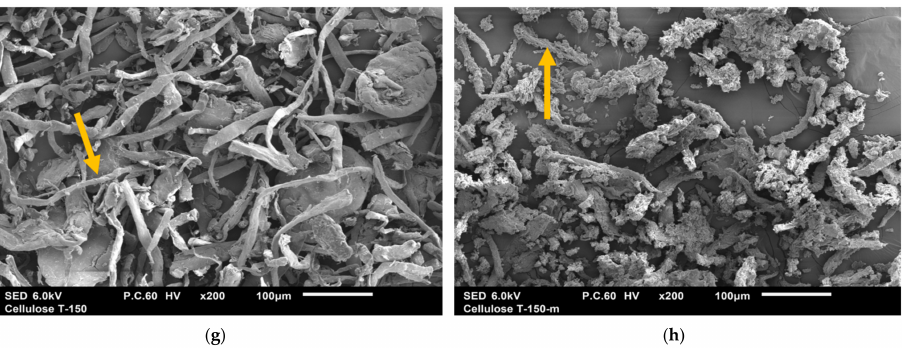
Figure 6. Scanning electron micrographs of cellulose fibers. Orange arrows point on the cellulose fibers, where surface morphology is especially noticeable. Working distance 11 mm, objective aperture (OA) 1. ( a ) Sigmacell not modified, magnification 600 × ; ( b ) Sigmacell modified, magnification 600 × ; ( c ) T-40 not modified, magnification 200 × ; ( d ) T-40 modified, magnification 200 × ; ( e ) T-90 not modified, magnification 200 × ; ( f ) T-90 modified, magnification 200 × ; ( g ) T-150 not modified, magnification 200 × ; ( h ) T-150 modified, magnification 200 × .